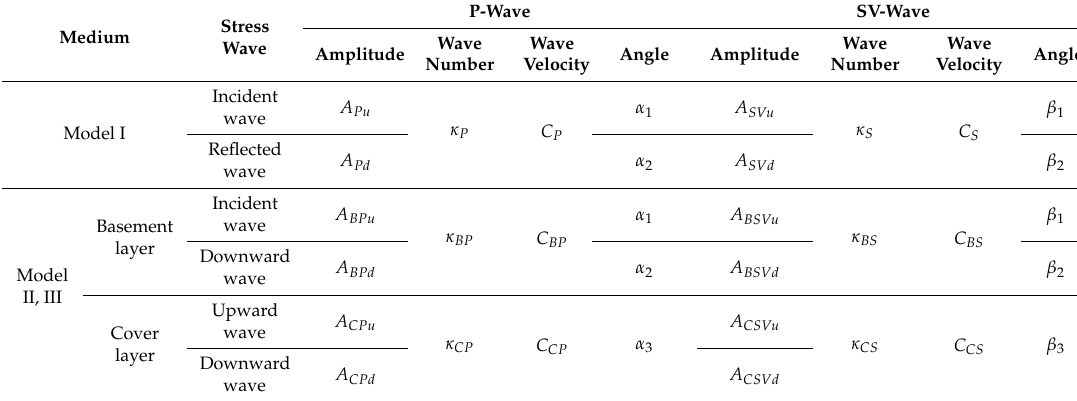
Table 1. Symbols of stress wave’s